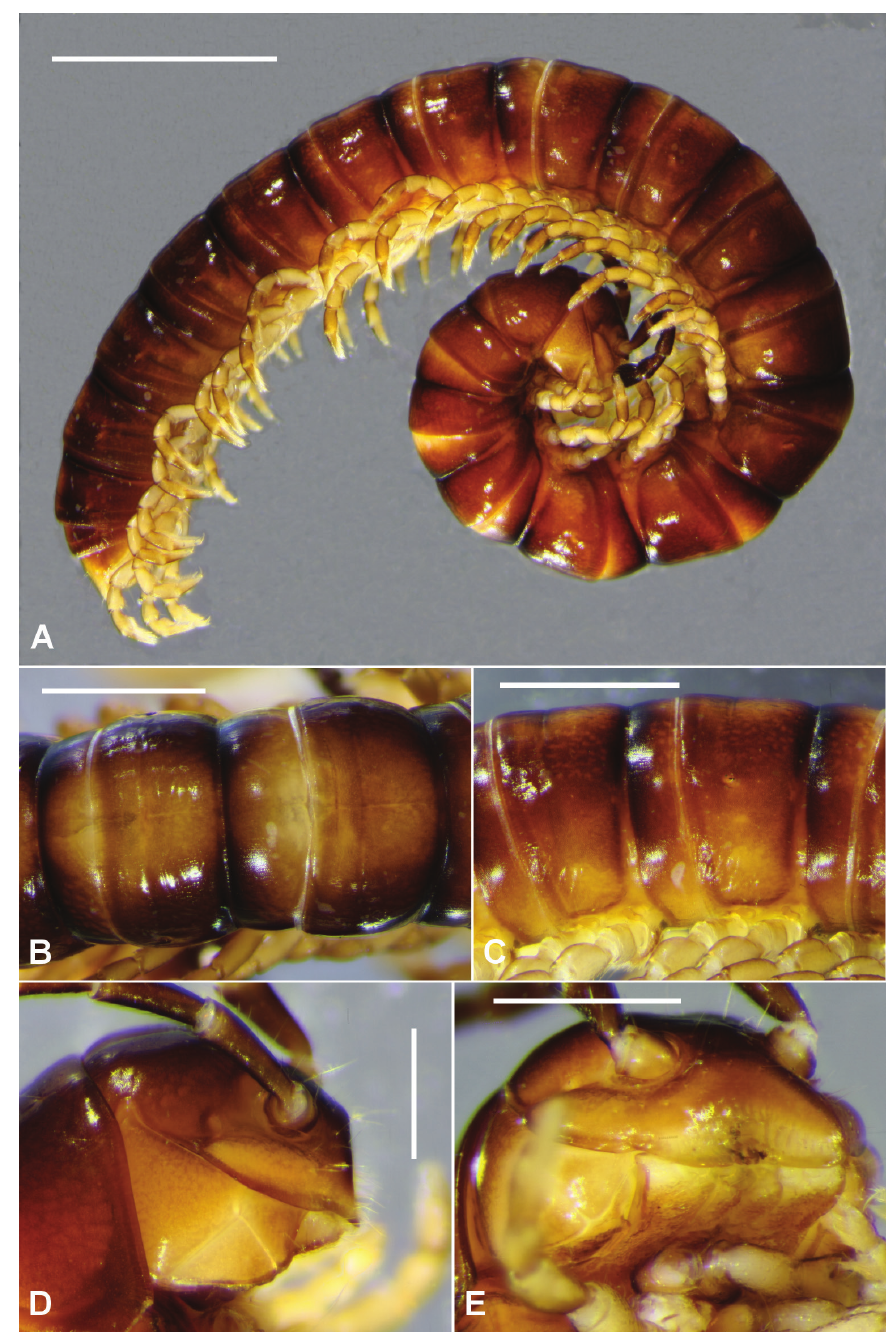
Figure 1. Taxidiotisoma portabile sp. n., male ex NMV K-12071. A Habitus B dorsal views of midbody rings C lateral views of midbody rings; anterior to right D Lateral views of head E oblique views of head. Scale bars: 2.5 mm ( A ); 1 mm ( B , C ); 0.5 mm ( D , E